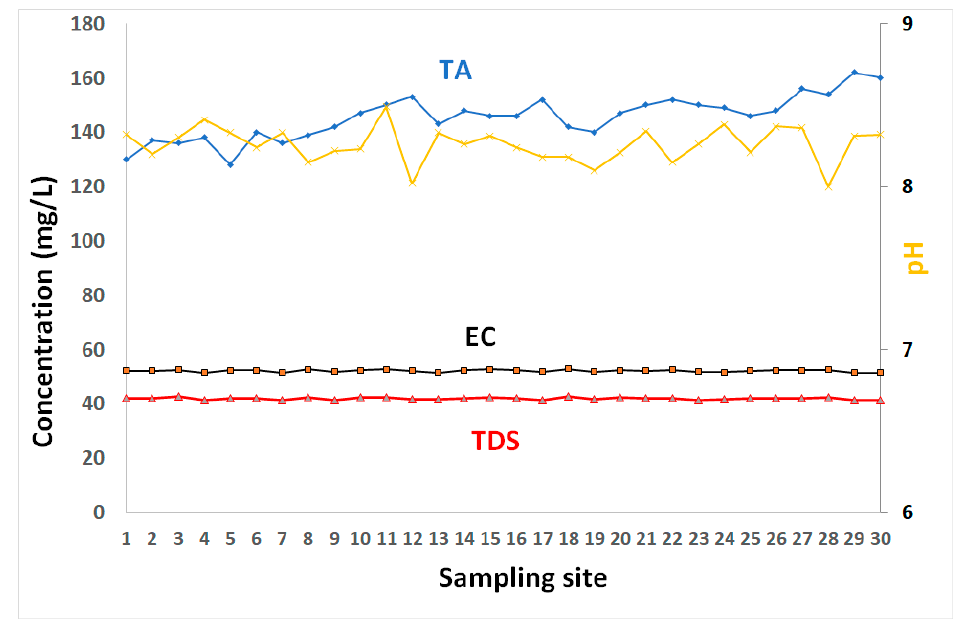
Figure 2. The electrical conductivity (EC), total dissolved solids (TDS), and pH of GoA coastal water.